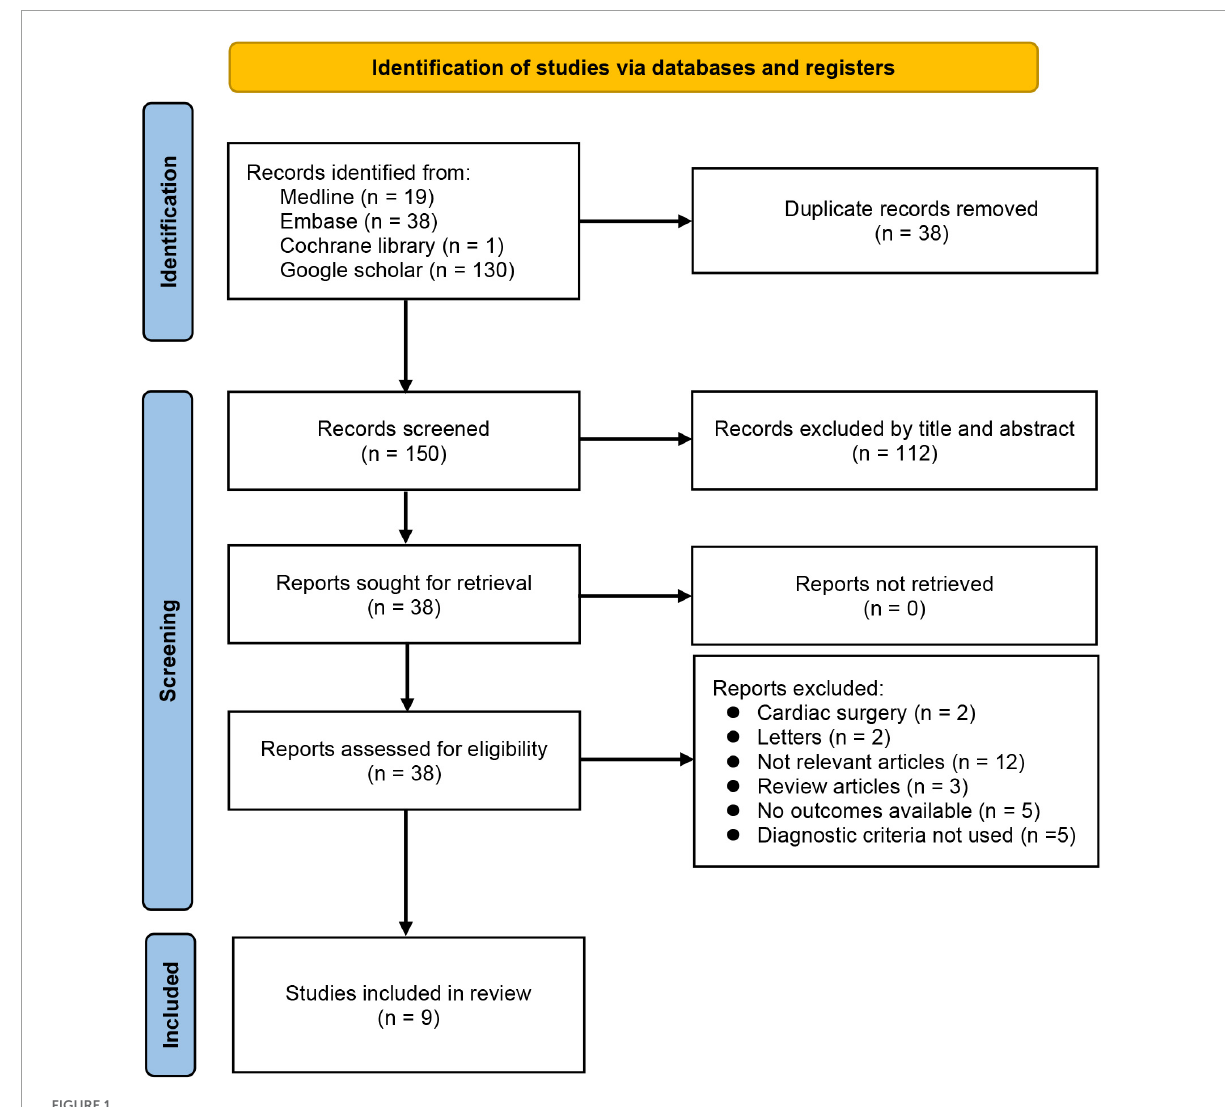
FIGURE1 PRISMA flow diagram of study selection for the current